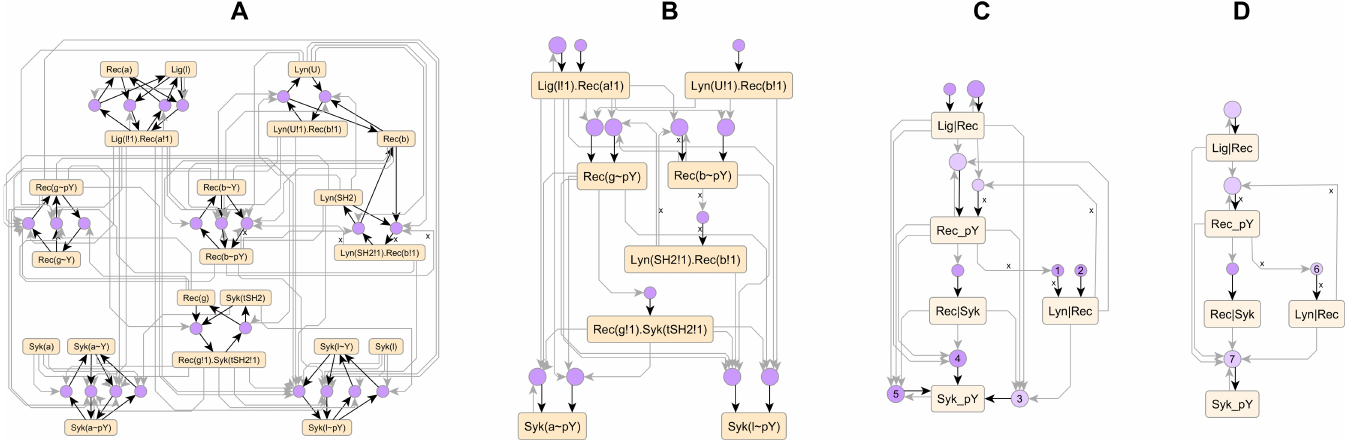
Fig 6. Atom-rule graphs of the immunoreceptor signaling model of Fig 1 at various levels of compression. (A) Full AR graph. (B) AR graph with low priority nodes removed. (C,D) Compressed AR graph followinggroupingand merging of nodes with a strict edge signature(C) or a permissive edge signature(D). For uncompressed versions of panelsC-D, see S2B–S2CFig.